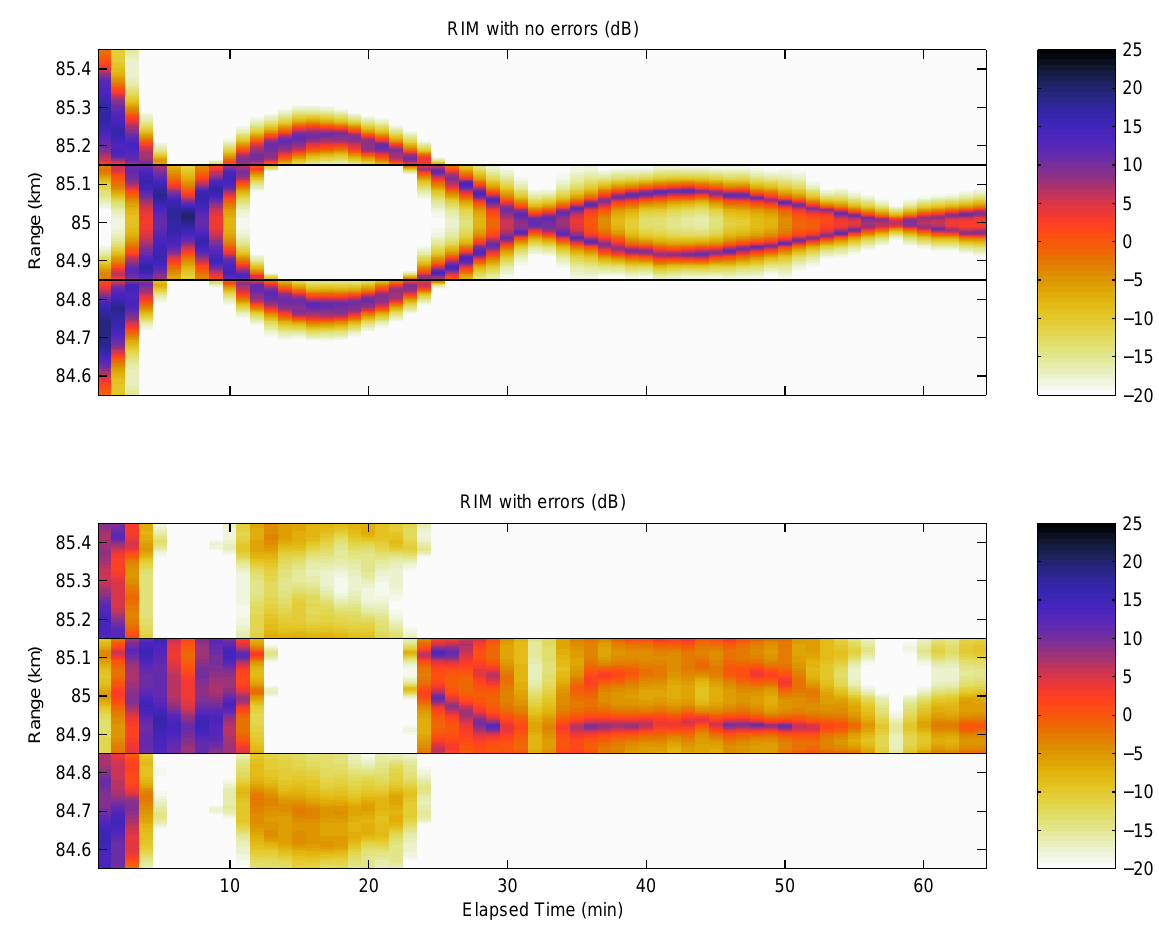
Fig. 5. Capon RIM image without phase error and infinite SNR is shown in the top panel. After inclusion of randomly chosen, but constant, phase errors, the image is severely distorted and is provided in the bottom